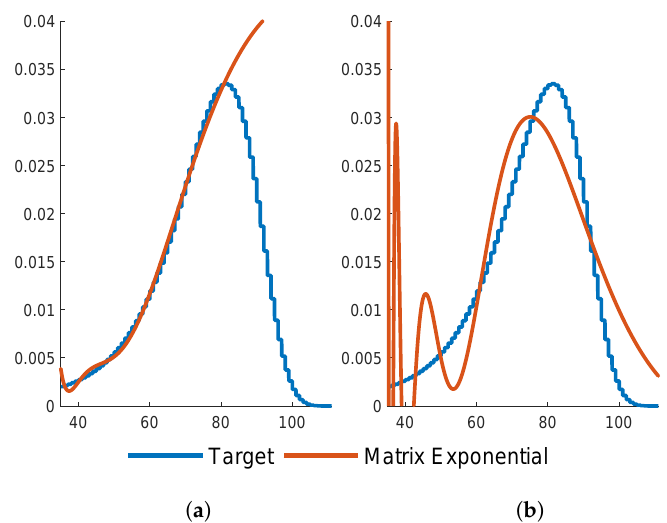
Figure A2. Sum-of-exponentials fits in age ranges 35–85 (left) and 35–110